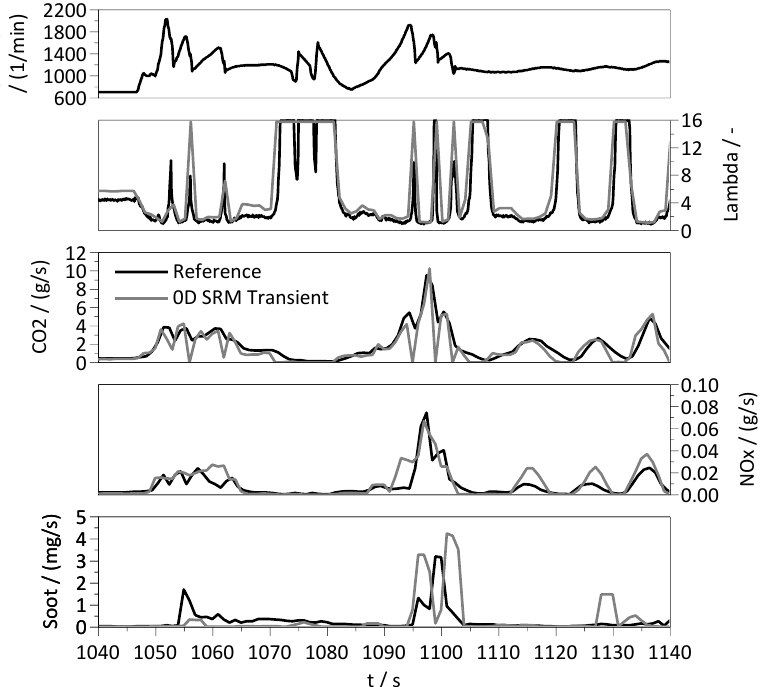
Figure 11. Comparison of λ , CO 2 , NOx, and soot mass flow values between simulation and reference measurements in a zoomed section of the WLTC.